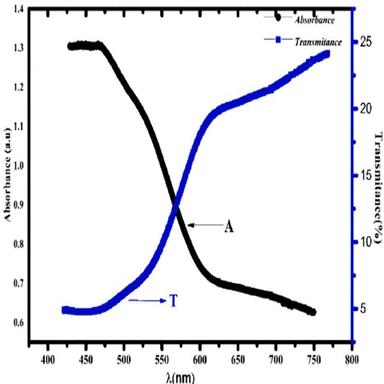
Absorption and transmission spectra of La2SrFe2TiO9.